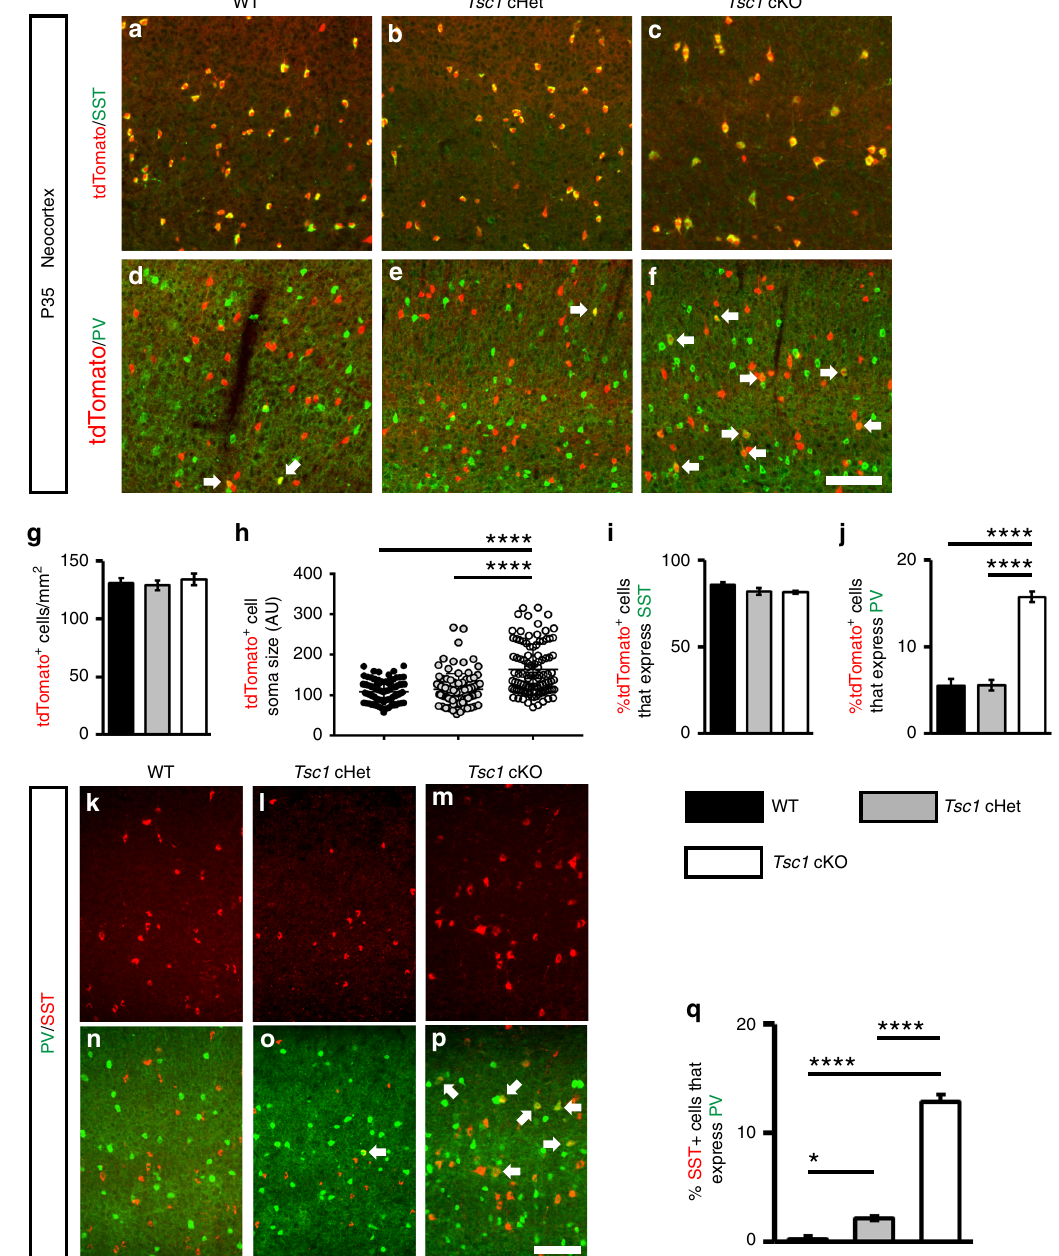
Fig. 1 Post-mitotic deletion of Tsc1 in SST-Cre -lineages results in increased PV expression. Coronal immuno fl uorescent images from WT, Tsc1 cHets or Tsc1 cKOs P35 neocortices, showing co-localization of tdTomato ( SST-Cre -lineages) with either SST ( a – c ) or PV ( d – f ). Arrows d – f denote cells in the SST-Cre - lineage that express PV. g Quanti fi cation of the number of tdTomato + cells/mm 2 (cell density) in the neocortex: n = 6 (WT), 6 (cHet) and 4 (cKO) mice, One-way ANOVA (F 2, 13 = 0.35, P = 0.7). h Quanti fi cation of tdTomato + cell soma size: n = 4 mice per genotype (100 cells measured from